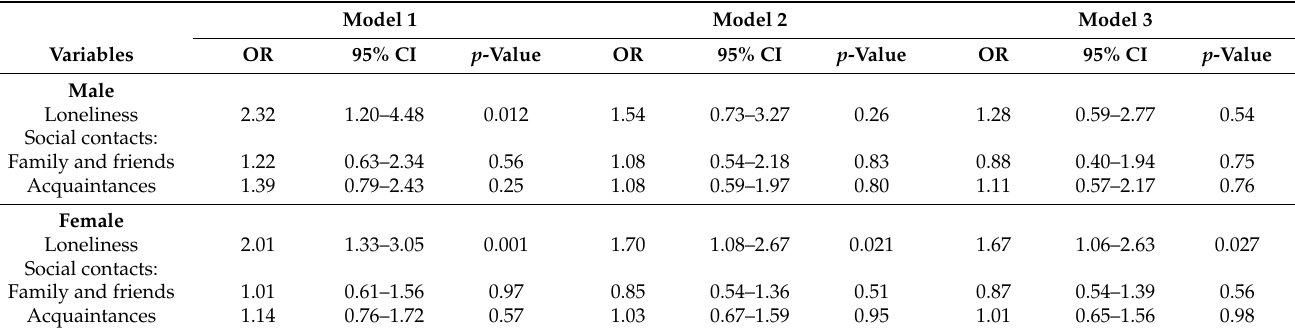
Table 3. Senior house residents’ odds for loneliness using binary logistic regression analysis and for social contacts using ordinal logistic regression analysis. Community-dwelling older people as a reference